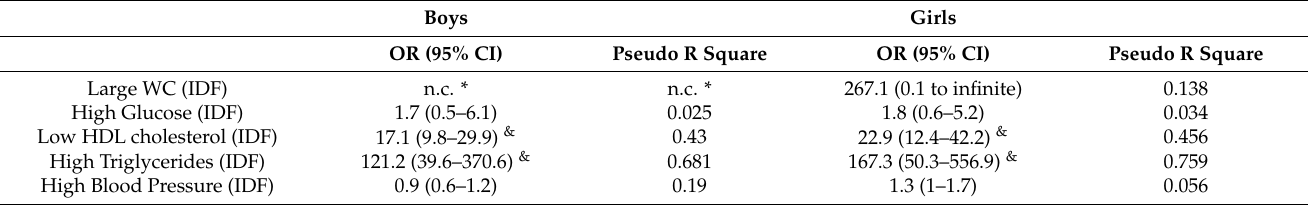
Table 5. Odds ratio and 95% confidence interval for cardiometabolic risk factors across TG/HDL adjusted for